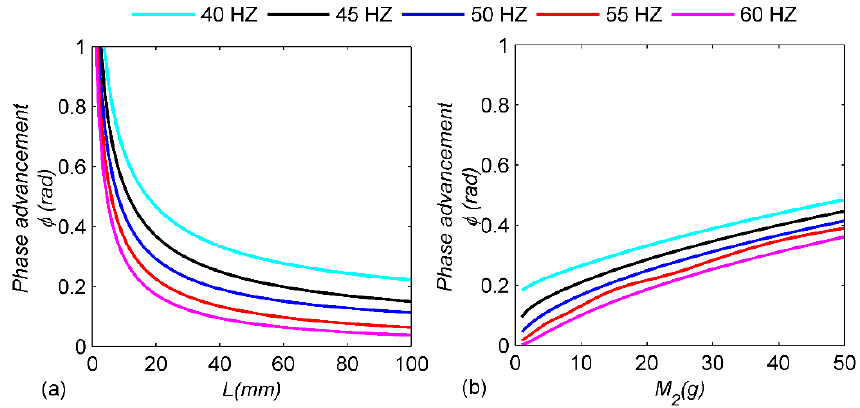
Figure 12. Parameter analysis of the pendulum mechanism: ( a ) the length of the cycloid L ; ( b ) the mass of the pendulum ball M 2 .